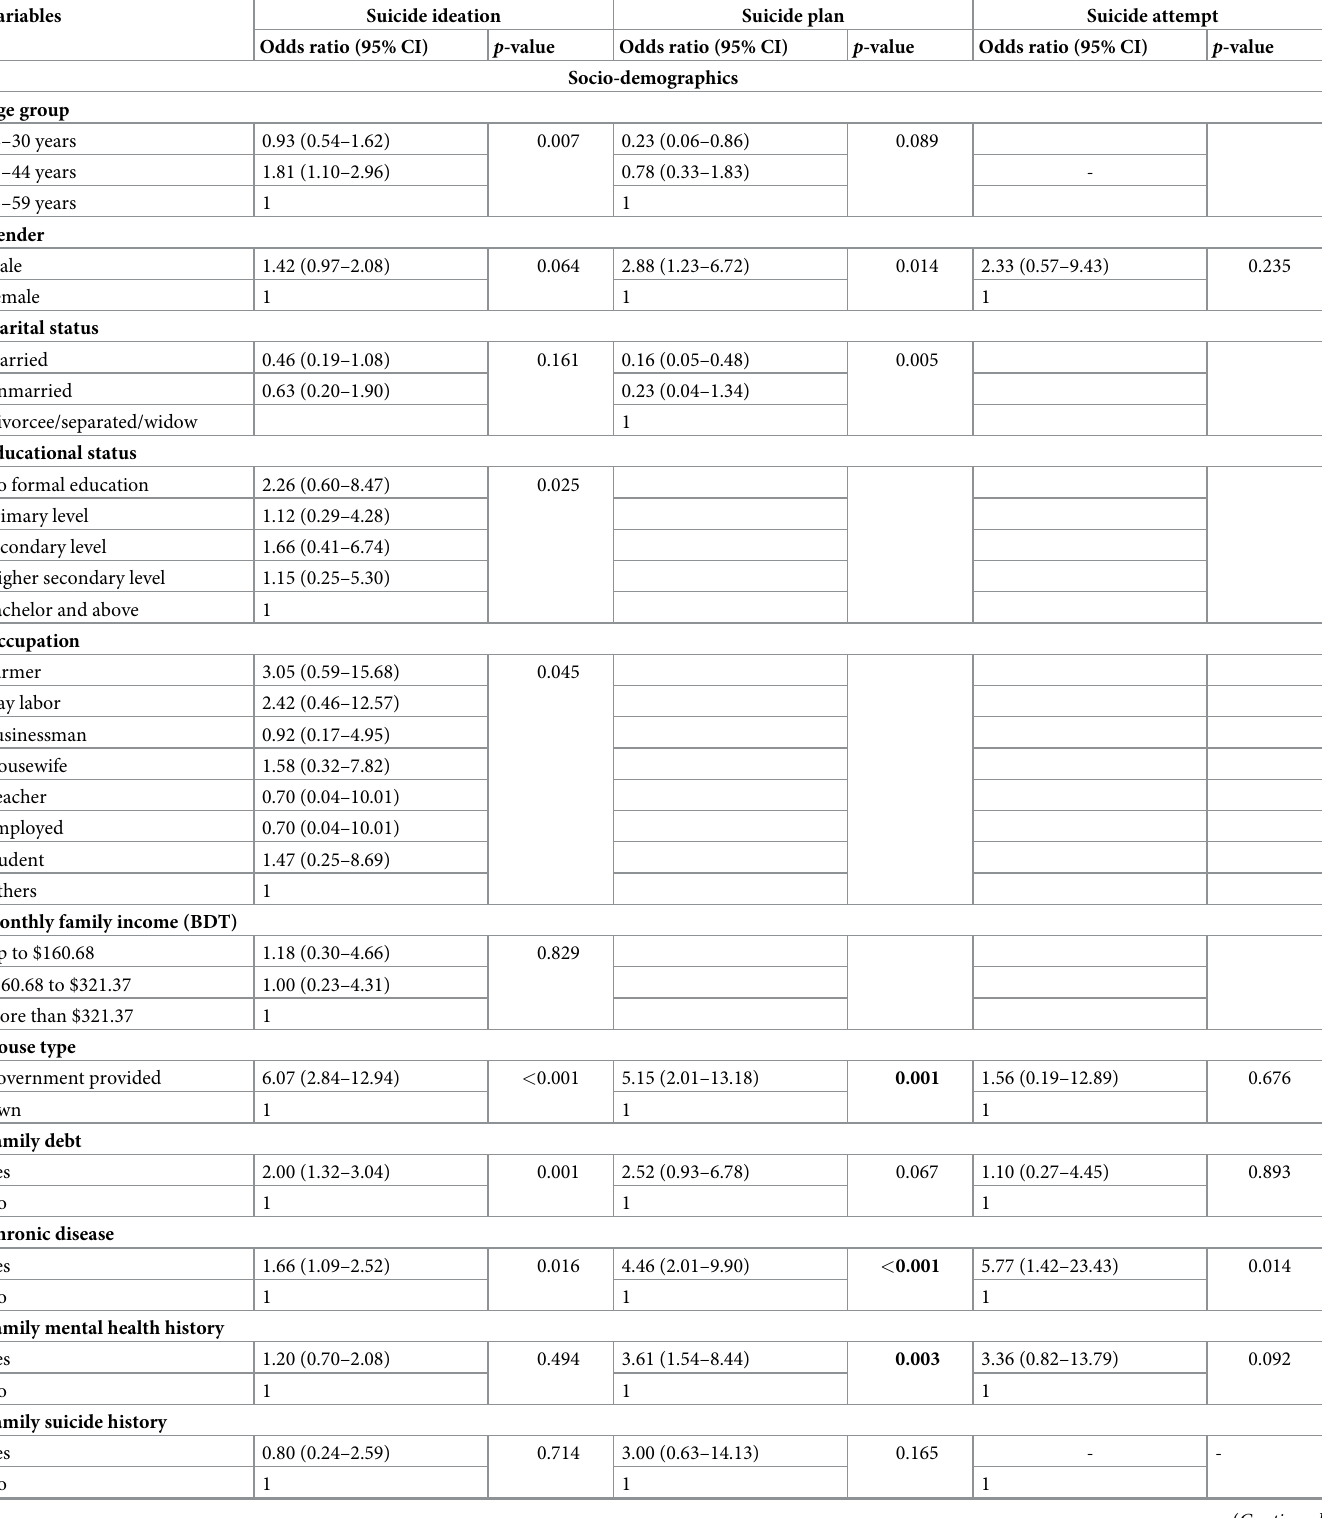
Table 5. Factors associated with lifetime suicide